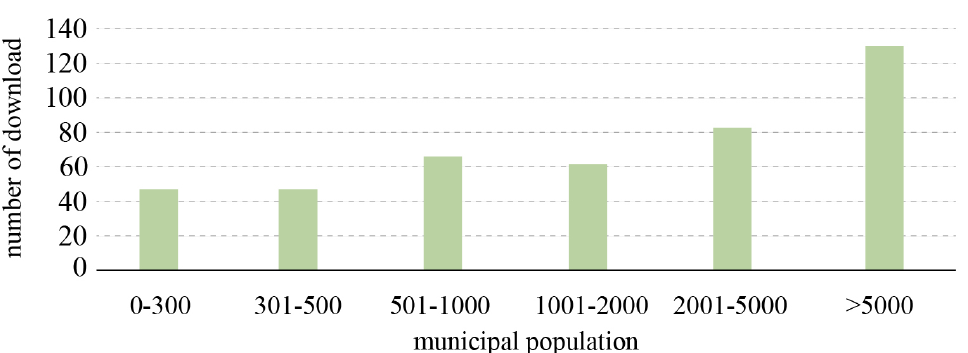
Figure 2. Bar chart showing the number of downloads of the Methodology by population in the municipalities.